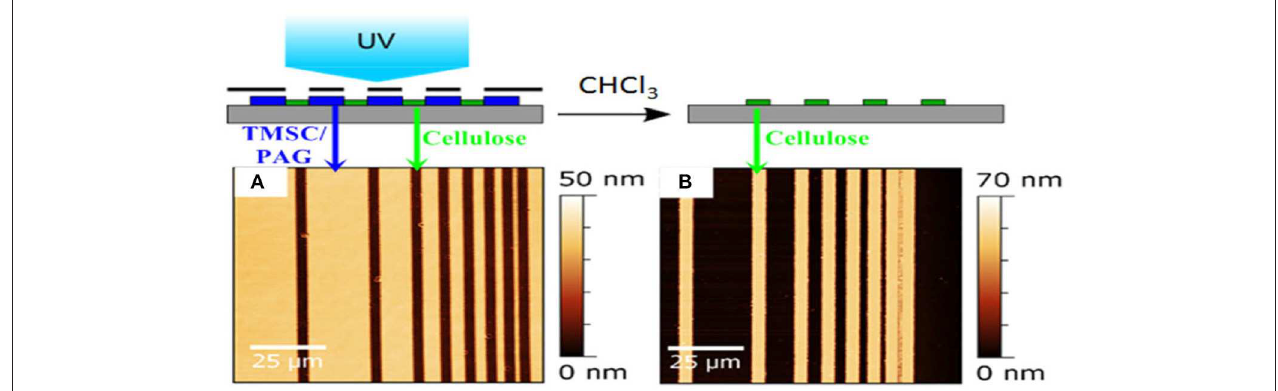
FIGURE 7 | AFM images of TMSC ultrathin films using a photolithographic mask after irradiation (A) and rinsing (B) . The smallest structure has a size of ca. 1 micron and wavelengths below 365nm have been excluded by an emissive filter to prevent degradation of cellulose during the illumination step. [Reproduced from Wolfberger et al., 2014 under the terms of the Creative Commons Attribution (CC-BY) license].